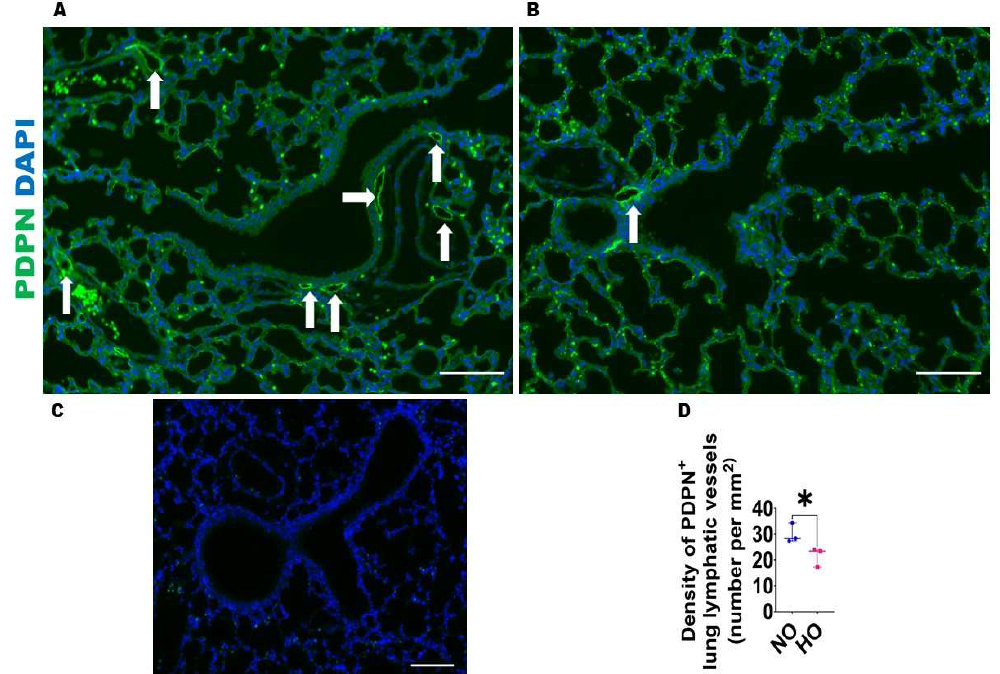
Figure 6. Lung PDPN + lymphatic density in neonatal mice exposed to HO . The lung lymphatic den- sity was determined by quantifying PDPN + lung vessels (arrows) on P14 in WT mice exposed to 21% O 2 (NO) or 70% O 2 (HO) from P1 to P14. A-B. Representative PDPN + (green) and DAPI (blue) immunofluorescence-stained lung vessels from mice exposed to NO ( A ) and HO ( B ) for 14 d. ( C ). Representative lung section from NO exposed animals stained with secondary antibody only (neg- ative control). Scale bar = 100 µm. ( D ). The quantification of PDPN + lung vessels. Values are pre- sented as the median with the range ( n = 4/group). Significant differences between exposures are indicated by **, p < 0.01 ( t -test).